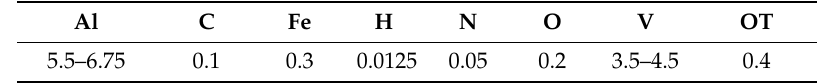
Table 2. The chemical composition of T1-6Al-4V titanium alloy according to AMS 4928 standard [1]. Al C